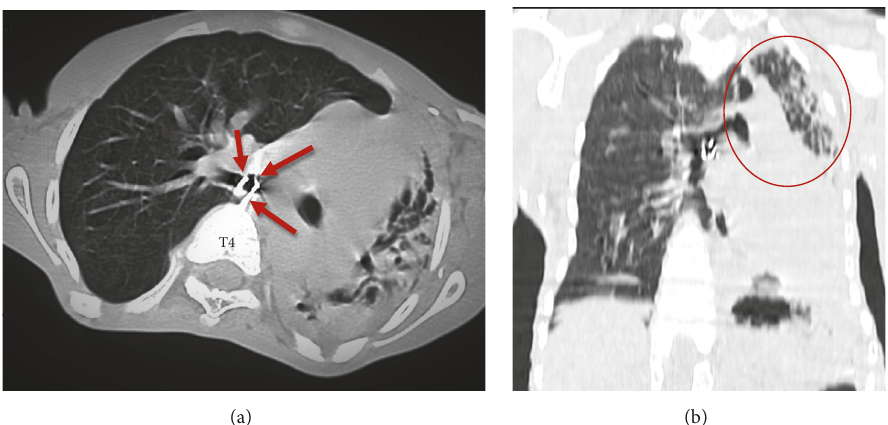
Figure 3: ((a) = axial section and ((b) = coronal reconstruction): Linear thick extraskeletal, parietal, tracheal, and left bronchial strain calcium formation, circumferential with intraluminal extension, attached to the anterior surface of the T4 vertebral body by a thick extension ((a): red arrows). CT in pulmonary window: atelectasis of the left pulmonary lobes ((b): red circle).